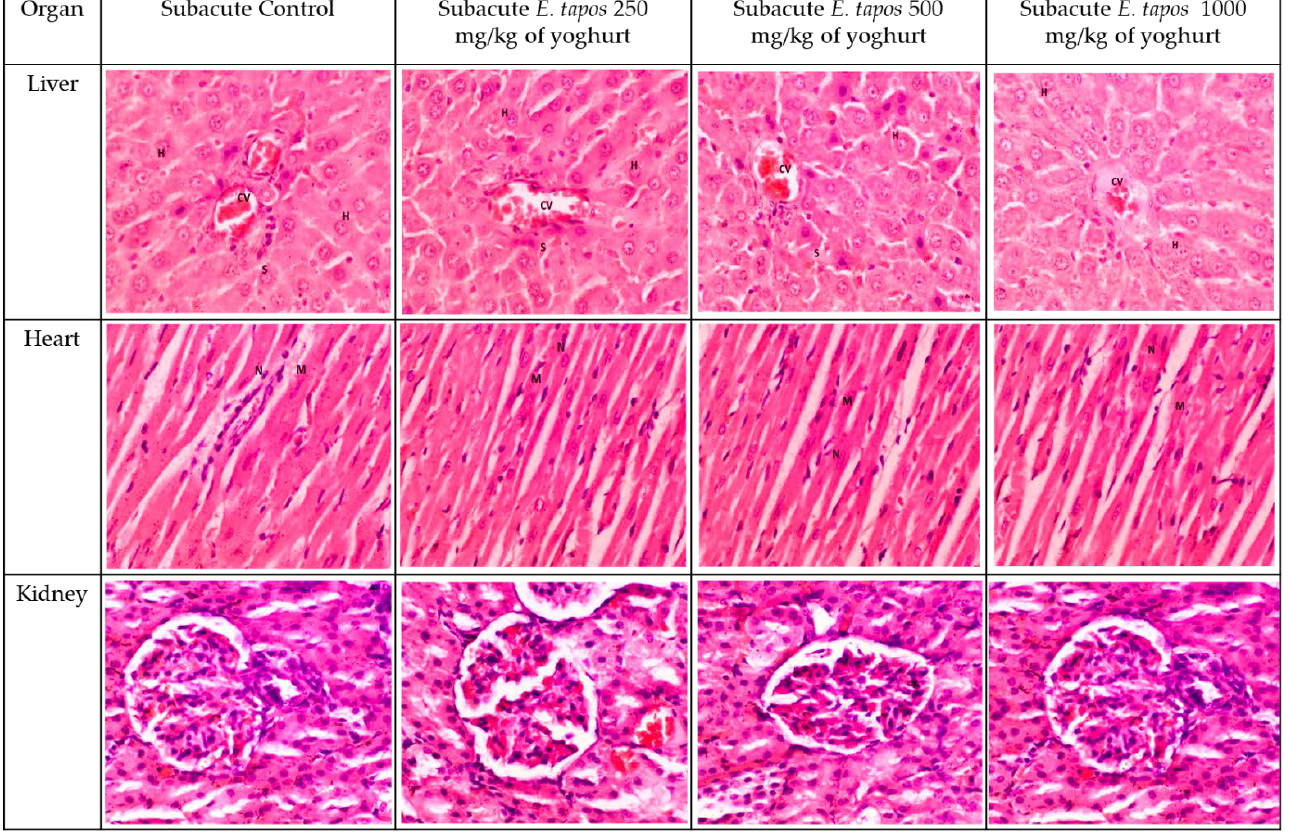
Figure 2. The histology section for subacute studies. The liver section shows standard strands of hepatocytes (H), sinusoids (S), and central vein (CV). It shows 0% of biopsied hepatocytes affected. The liver grading scores were documented as 0 due to absence of steatosis, lobular inflammation, and hepatocyte ballooning. The heart tissue showing normal heart architecture and no inflammation was observed. Myocardium (M) and nucleus (N). Kidney histology showed no lesion or tubular dilation. Renal corpuscle appeared normal. No abnormalities observed in the liver, kidney, or heart in subacute toxicity groups.